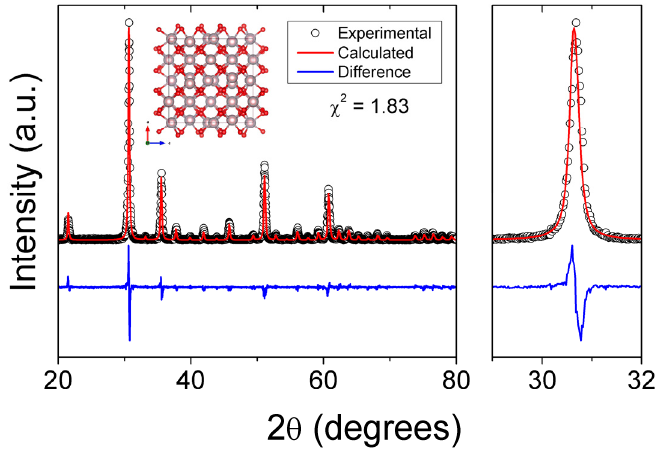
Figure 2. θ -2 θ X-ray diffraction pattern of the In 2 O 3 nanoparticles. The inset presents the cubic crystal structure of In 2 O 3 .